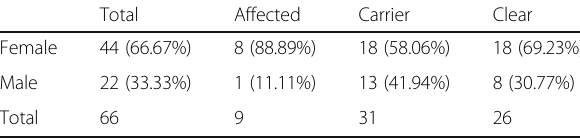
Table 6 Sex distribution of SP with comparison between genotypes